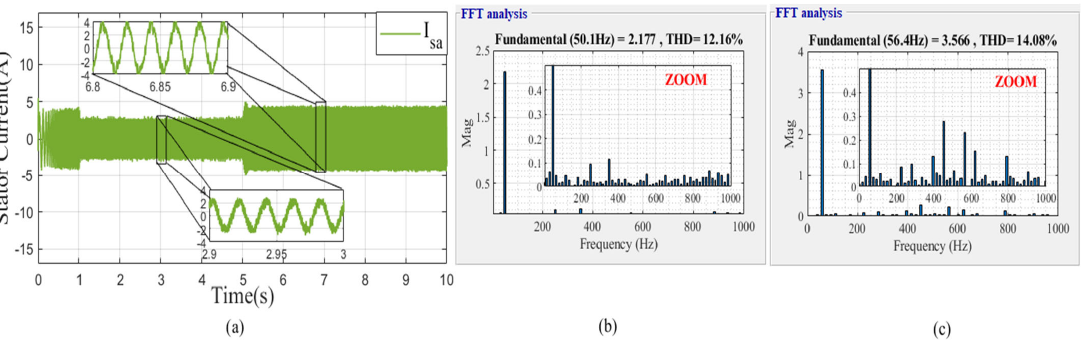
Figure 30. Performance with Cage bearing defect of IM with DTC control: ( a ) rotation speed and ( b ) motor torque.